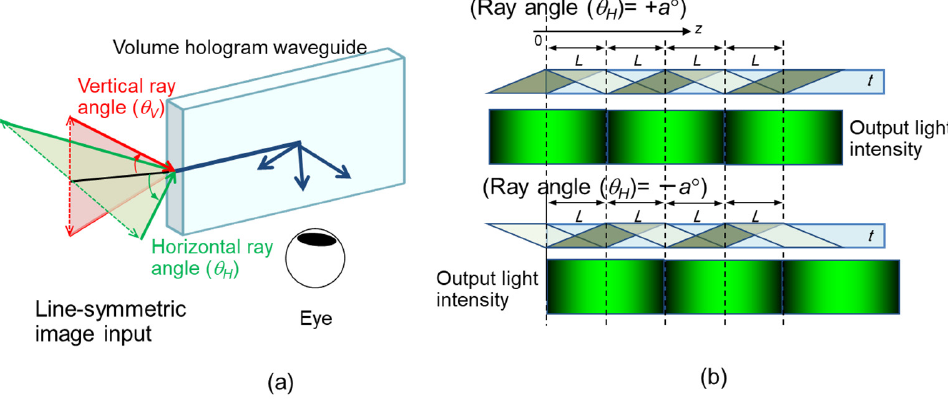
Figure 5. Schematic of ( a ) line-symmetric image input; ( b ) light-propagation pass and output-light intensity at each position of the waveguide.